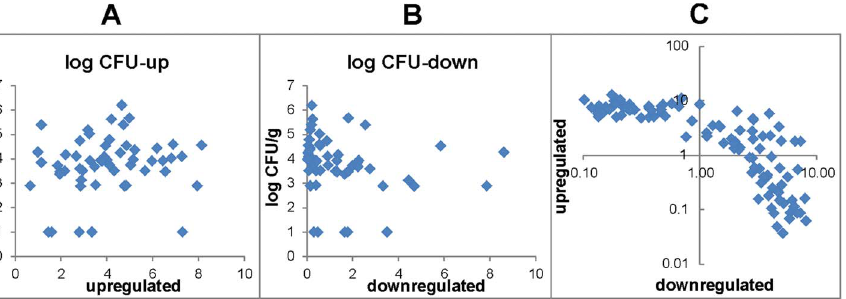
Figure 4. Correlation between gene expression and Salmonella counts in the liver (log CFU/g), and correlation between upregulated and downregulated genes. Each dot represents a single chicken characterized by Salmonella counts in the liver, average expression calculated from expression of all genes which positively respond to Salmonella infection or average expression calculated from expression of all genes which negatively respond to Salmonella infection. A, correlation between average expression of upregulated genes and Salmonella counts in the liver. B, correlation between average expression of downregulated genes and Salmonella counts in the liver. C, correlation between average expression of upregulated and downregulated genes.